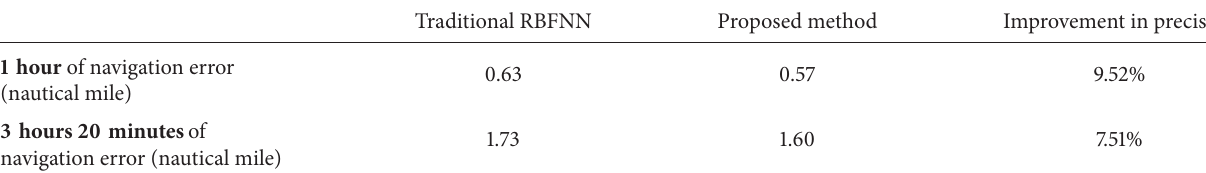
Table 3: Inertial navigation error in the airborne experiments.